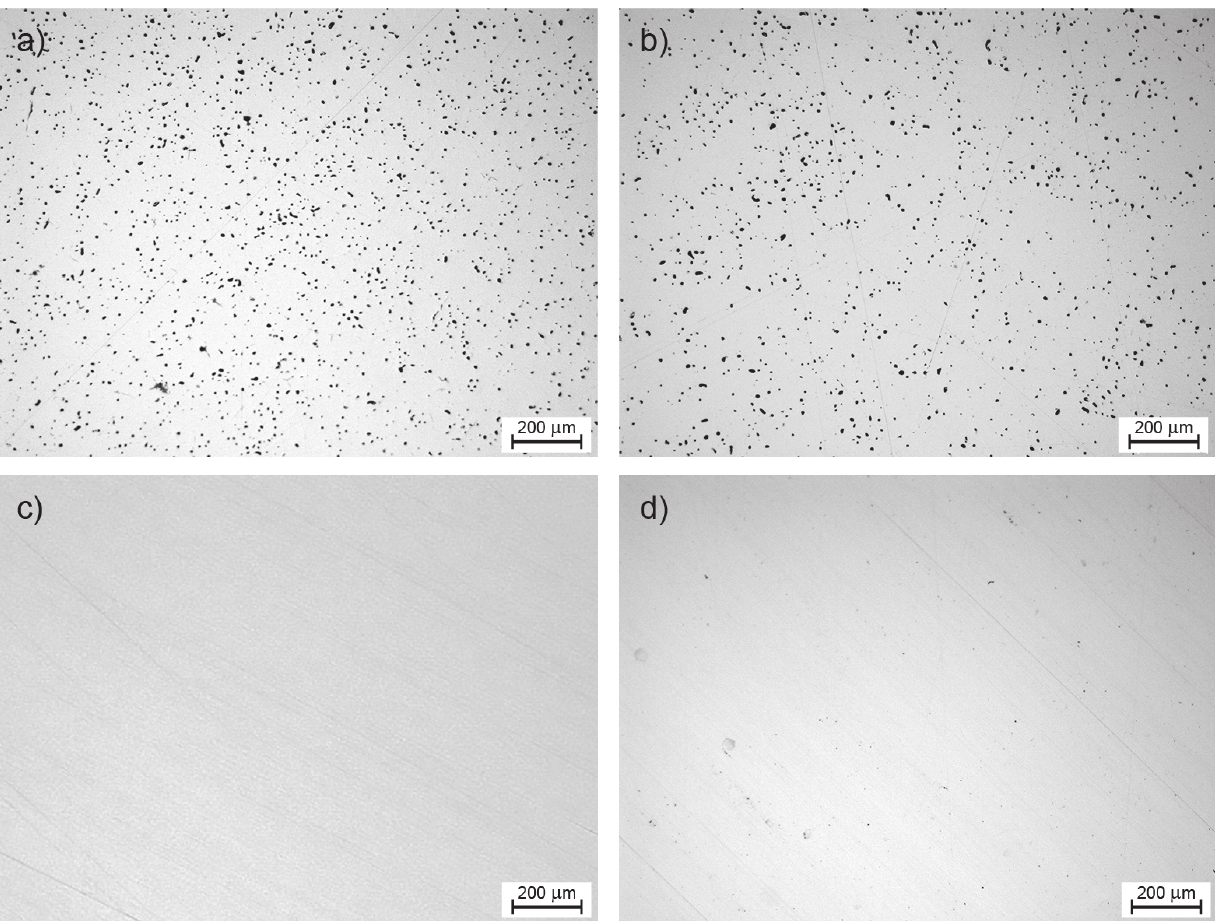
Figure 2. Sintering plateau and HIP treatment effect on the value of relative density.